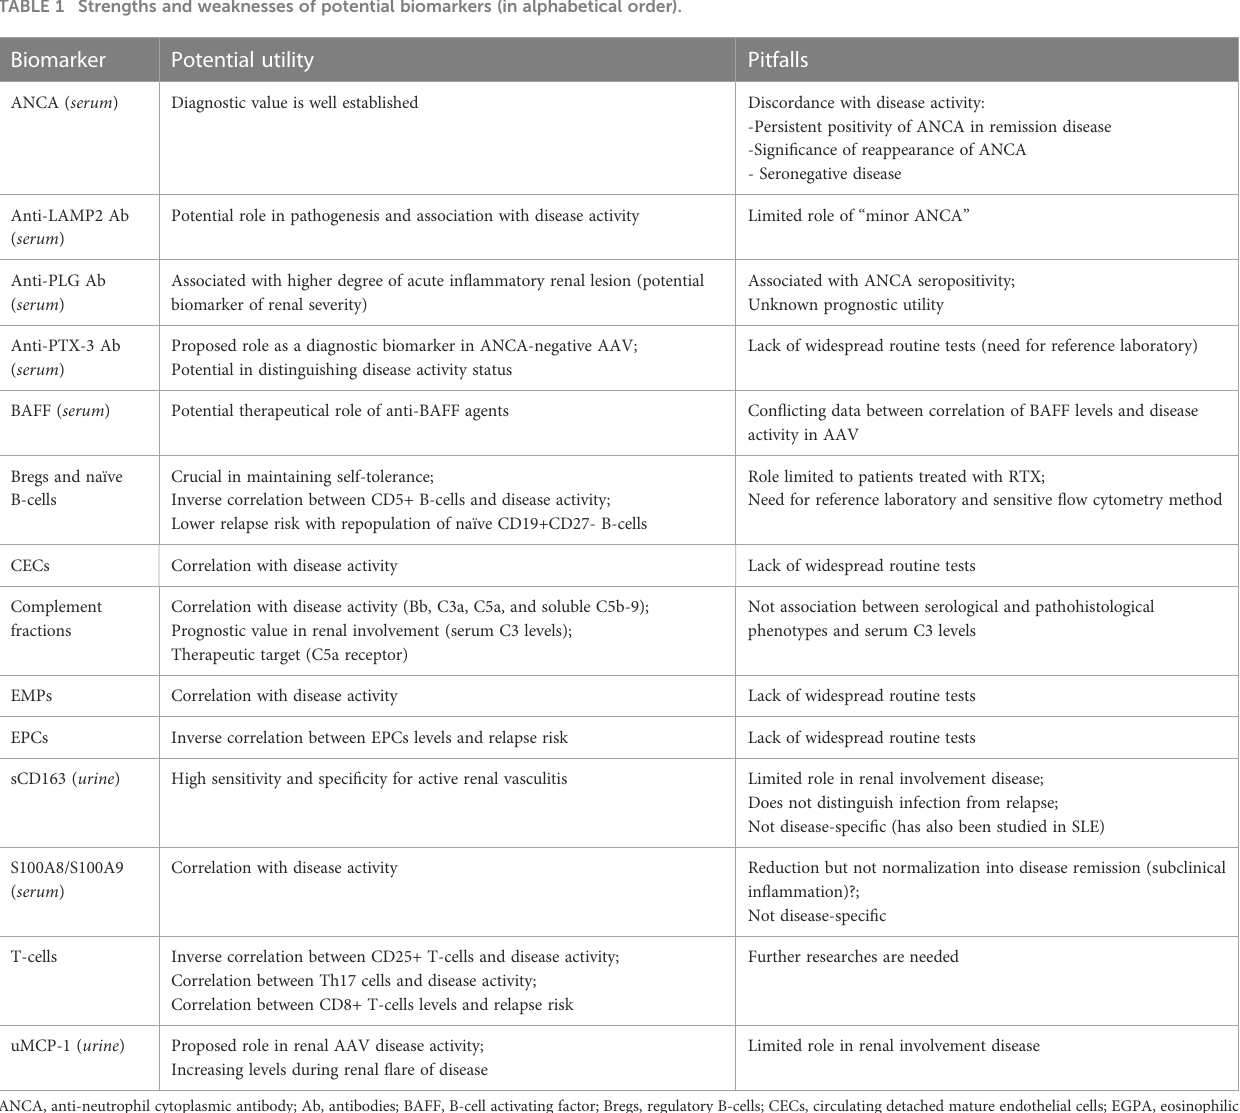
TABLE 1 Strengths and weaknesses of potential biomarkers (in alphabetical